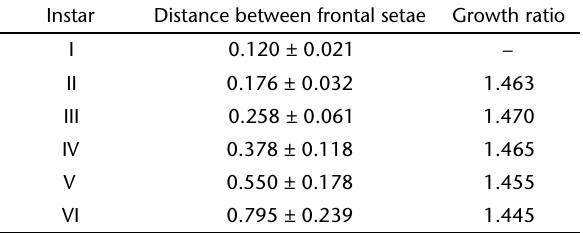
Table II. Mean and standard deviation of the distance between the frontal setae of the cephalic capsule of M. cruenta , by instar.